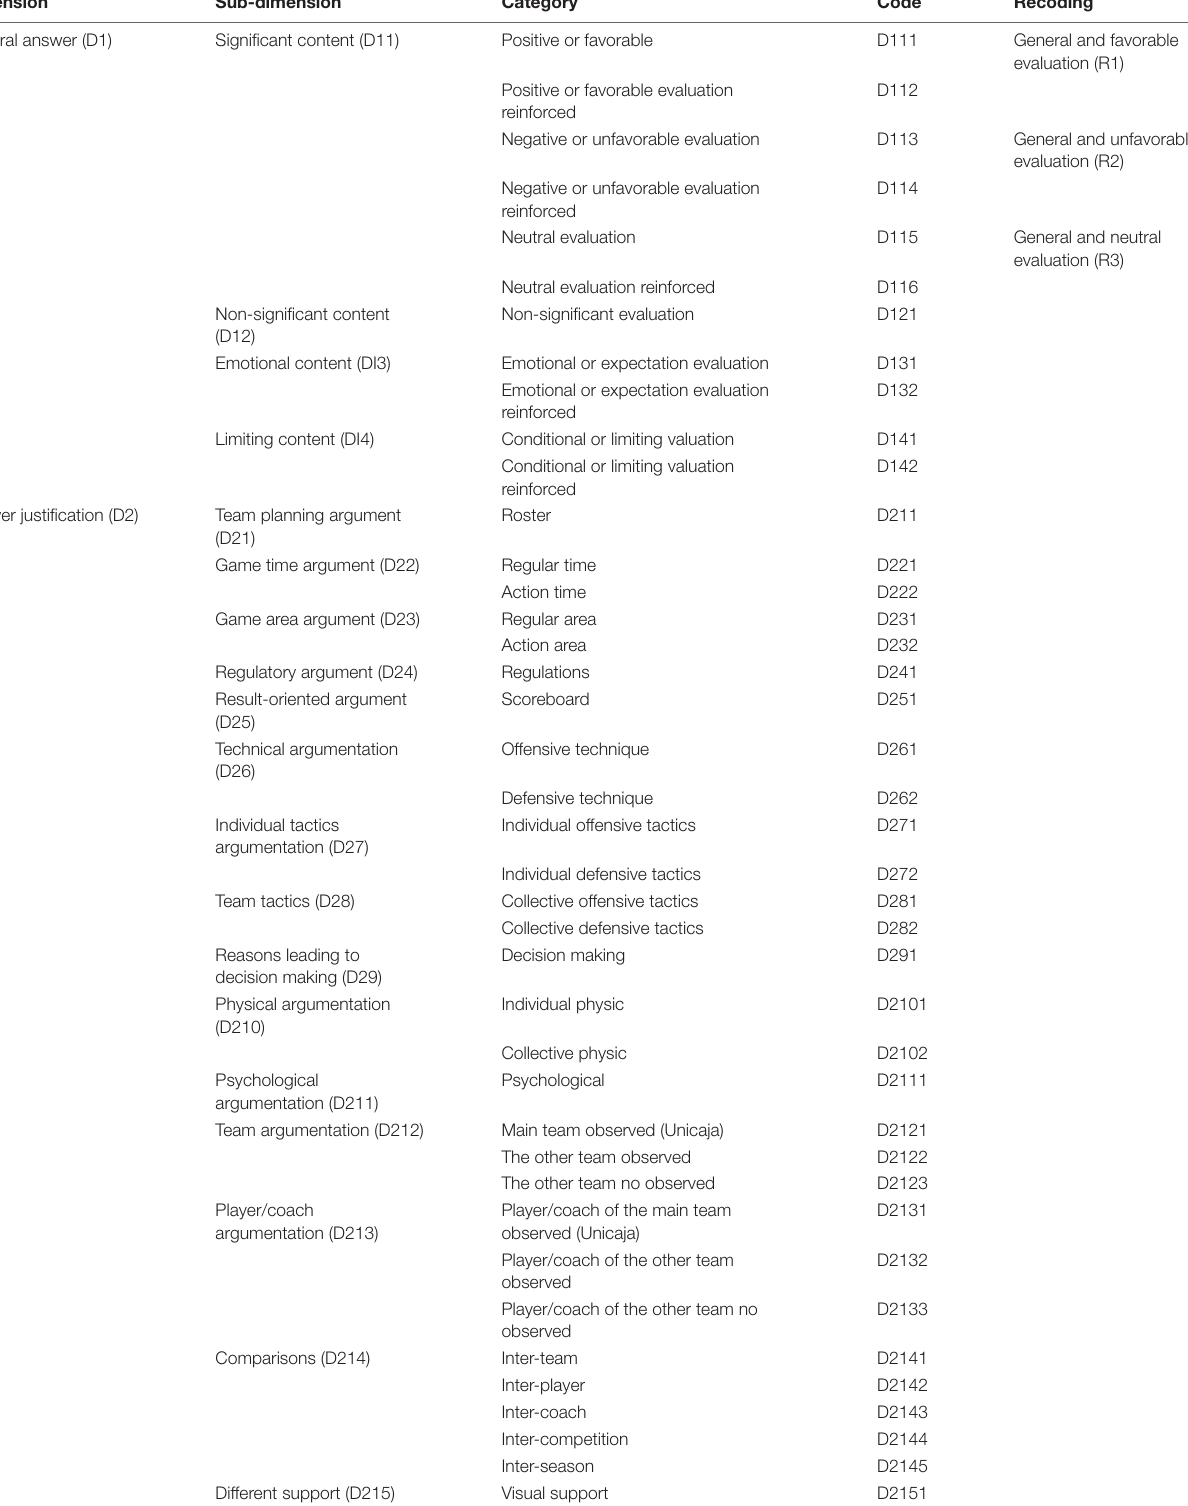
TABLE 2 | Indirect observation tool to analyze the narrative content of responses on the offensive and defensive aspects of